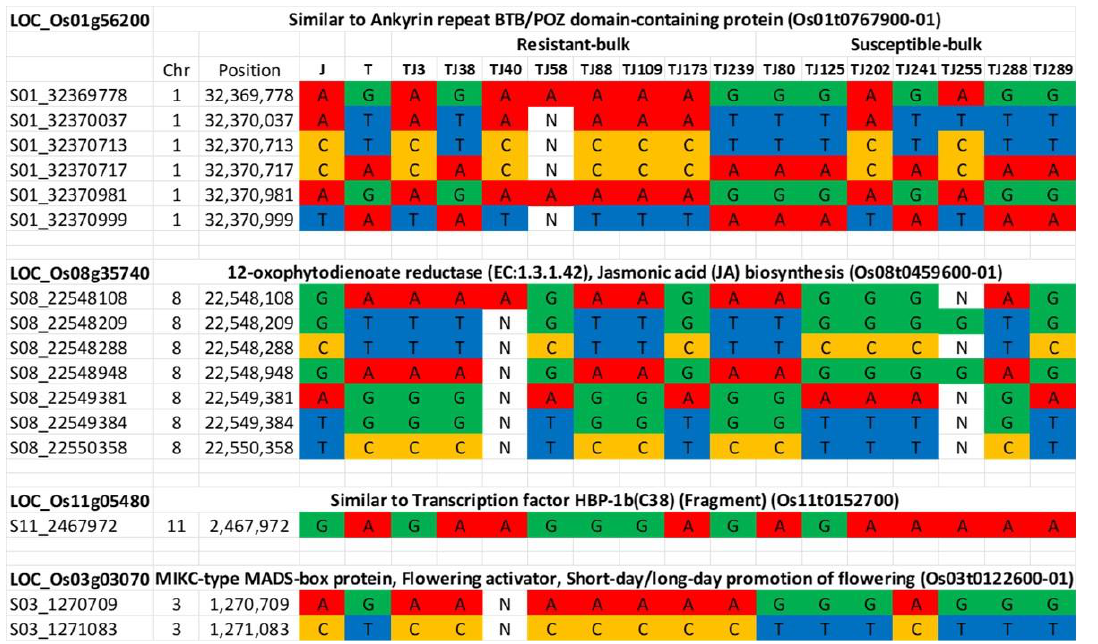
Figure 4. Genotypes across sixteen markers for the parents (Jupiter ‘J’ and Trenasse ‘T’) and individuals constituting the susceptible (7 RILs) and resistant (8 RILs) bulks. ‘N’ represents missing genotypes.